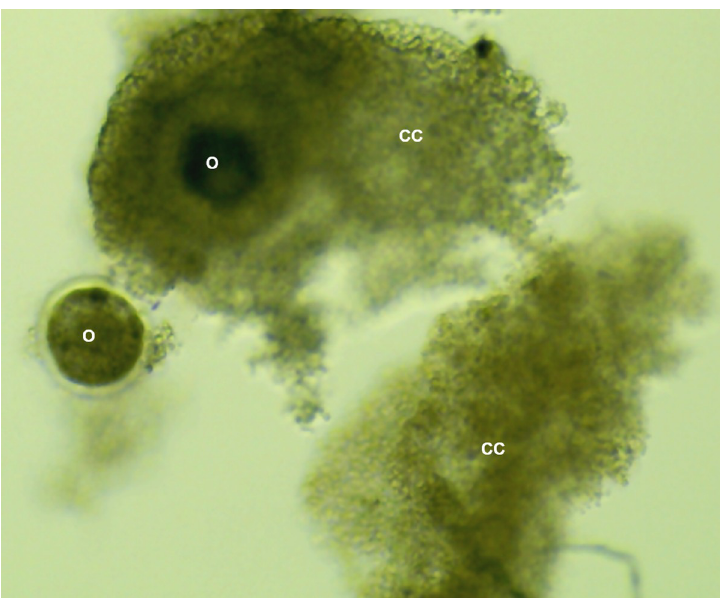
Fig 1. Image of partial disintegration of cumulus cells obtained by stereoscope microscopy. Experimental infection of bovine oocytes (O) with BHV1 showing partial disintegration of cumulus cells (CC). Magnification of 40x.